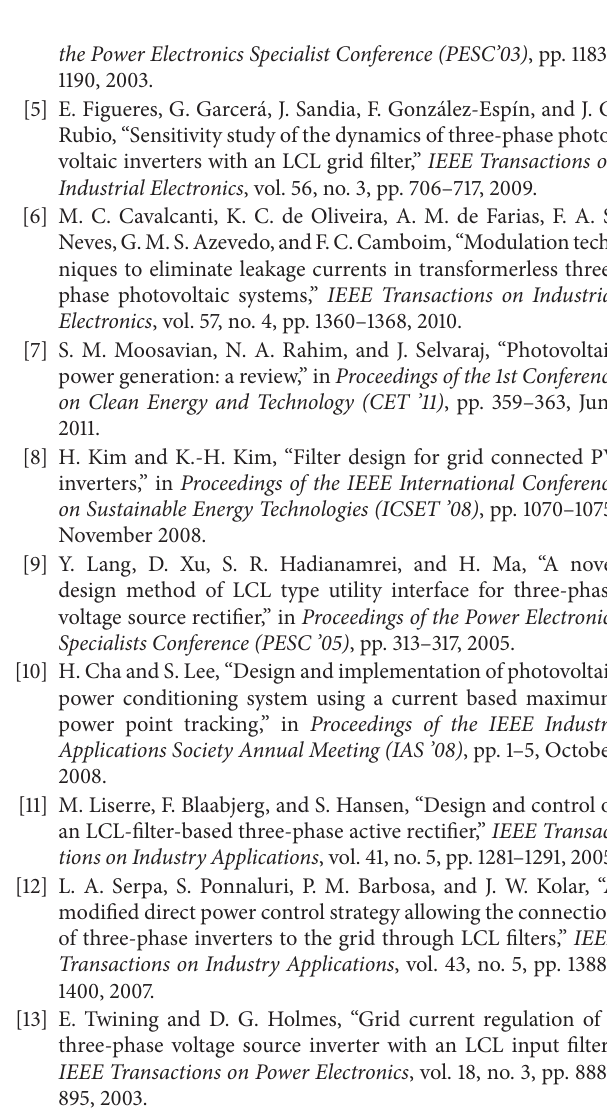
Figure 12: The three-phase load current with integrated filter inductor with three limbs: (a) the current of A phase and B phase, (b) the current of A phase and C phase. In CH1, the current comes from the current transformer and the proportion is 1V = 5 A; it means that the current per DIV is 5A; in CH2, the current per DIV is 5A; the time per DIV is 5 ms.